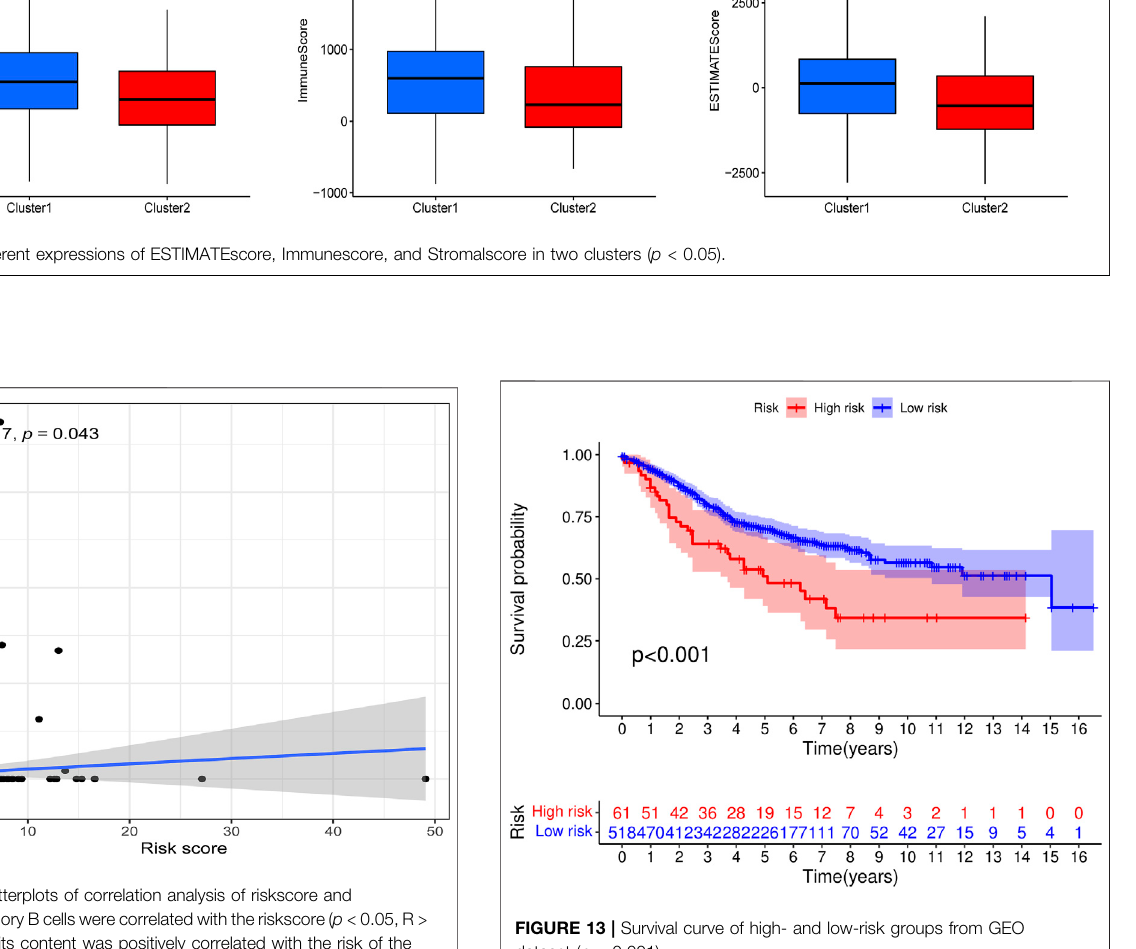
FIGURE 13 | Survival curve of high- and low-risk groups from GEO dataset ( p < 0.001).